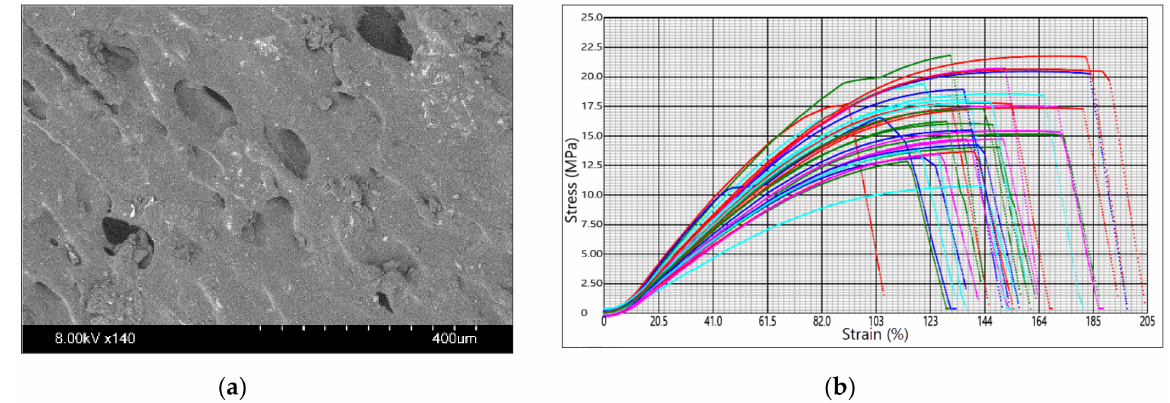
Figure 5. PHA BioWOOD Rosa 3D: ( a ) sample surface SEM image; ( b ) tensile test